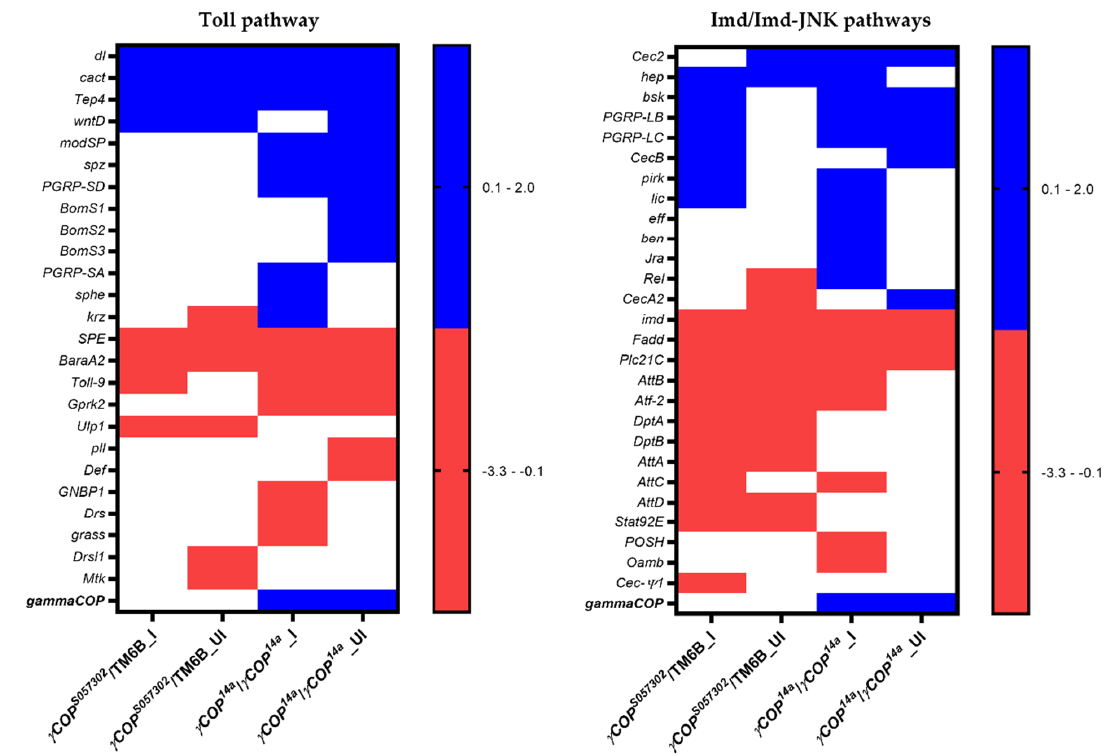
Figure 1. Heatmaps of genes having a significant expression variation in at least one mutant back- ground. The gene names are indicated on the left side of each heatmap (Toll pathway and Imd/Imd- JNK pathways). For each infected (I) or uninfected (UI) experimental condition, downregulated genes are colored in red, while the upregulated genes are indicated with blue. The white squares indicate that the expression variation was not statistically significant. The gene expression is expressed as log 2 FC.